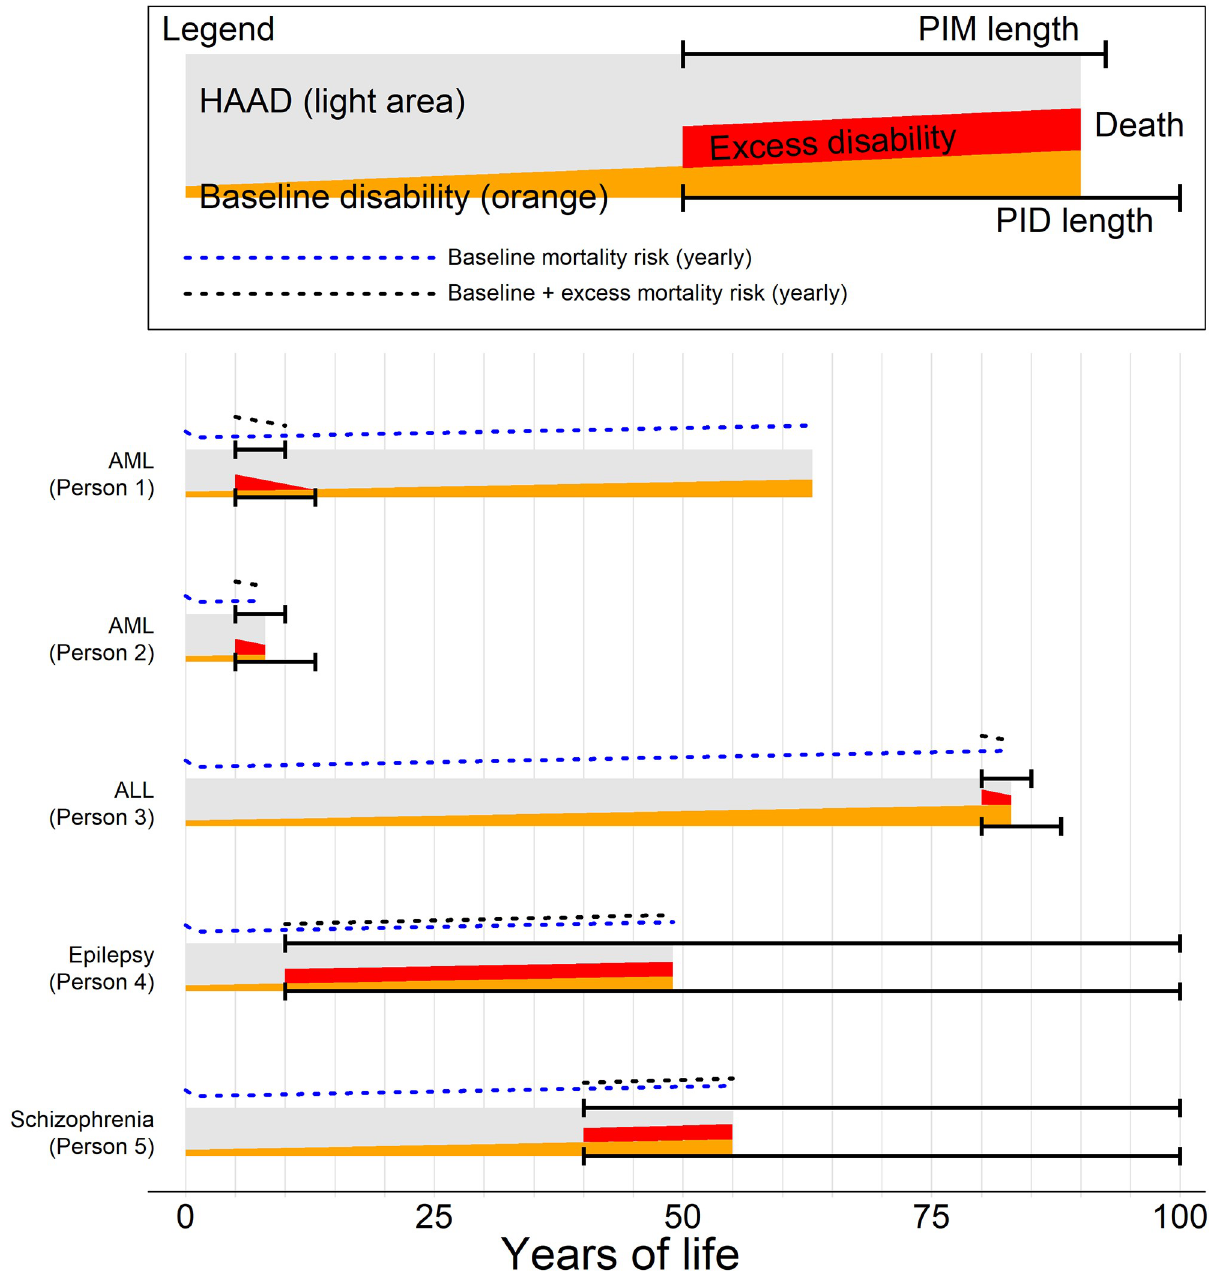
Fig 3. Outline of the conceptual structure of the Health Adjusted Age at Death (HAAD) method, where we calculate the sum of past health and expected future health for five individuals with different diseases (AML, ALL, epilepsy and schizophrenia). For a disease D, the dashed black line is baseline mortality (i.e., average mortality in the population), and the blue line is baseline mortality added to the excess risk of death caused by D. The grey area is HAAD D . The orange area is baseline health loss due to disability (dw), and the red area is health loss caused by D (dw D ). These areas slope upwards because disability increases with age. The sum of the grey, orange and red areas constitute age at death (AD). The top solid black line gives a period after the onset of D when the person had a period of increased mortality (PIM). The bottom line gives a similar period of increased disability (PID). Note that PIM and PID may be over before death occurs because the individual has survived the course of the disease, as seen in the top example, or PIM and PID may last beyond the death because the person died during the course of the disease, as seen in the other examples.